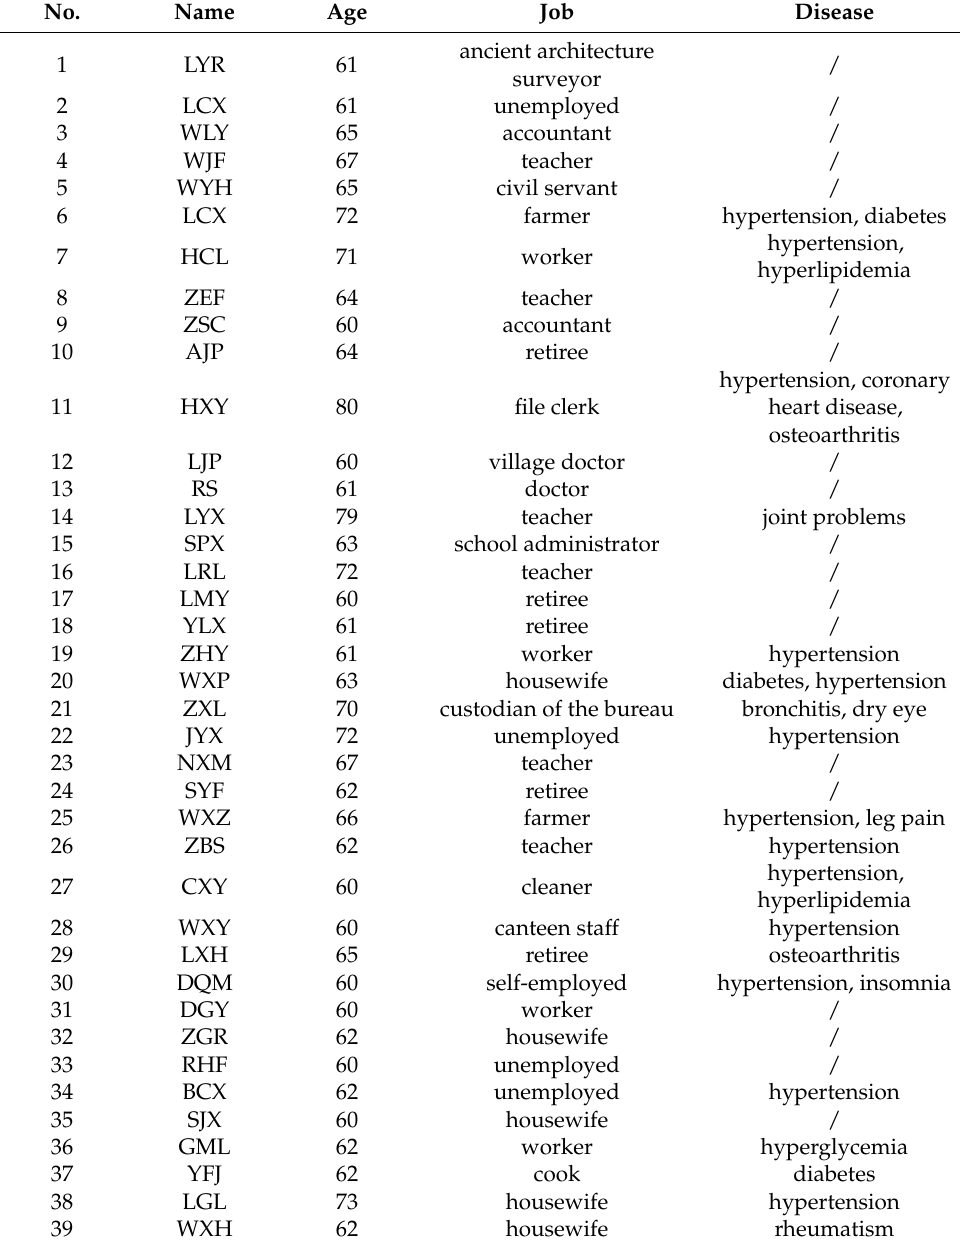
Table 3. Basic information on the